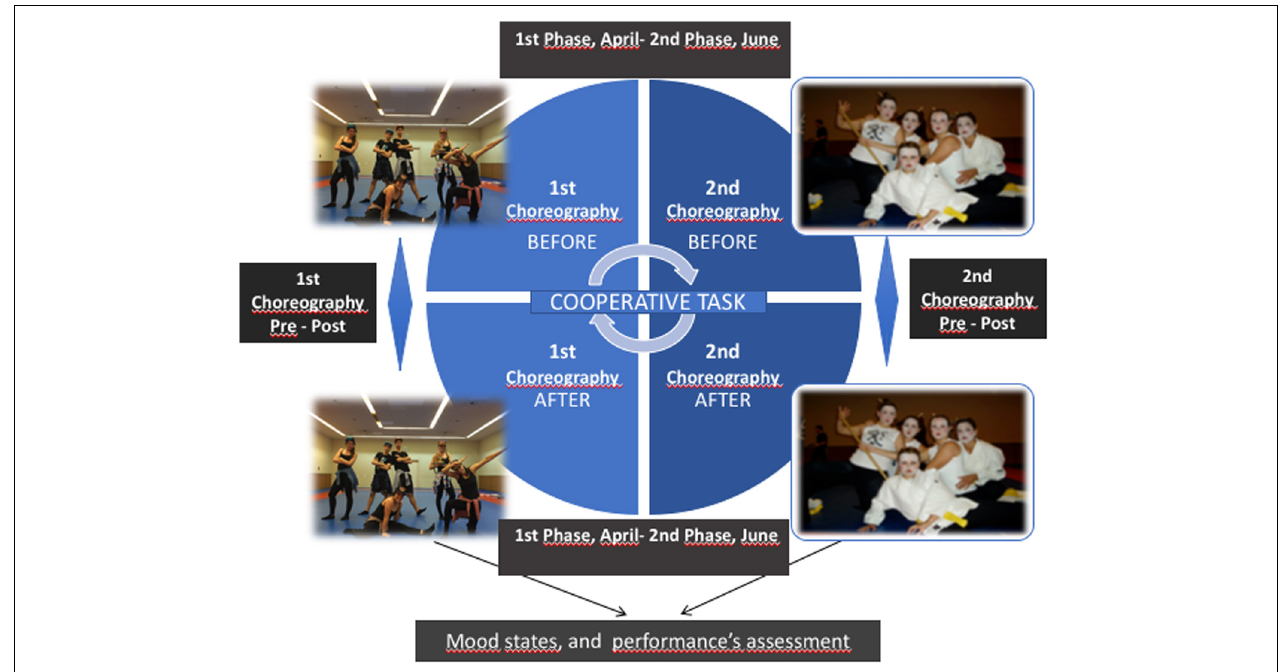
FIGURE 1 | Methodological